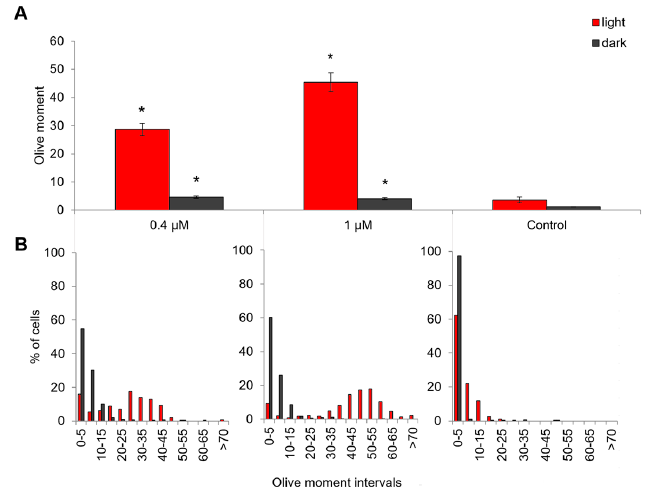
Figure 6. The level of DNA damage in HeLa cells in the dark and after activation with light ( λ = 660 nm), estimated with Comet assay (2 h in the dark then 20 min under red light then 6 h in the dark). At the Figure ( A ), there are average values of the six experimental repeats, within each repeat 50–80 cells were analyzed; At the Figure ( B ) the distribution of the number of cells according to Olive moment is shown with the interval being equal to five units in each variant. *—the difference from control (Solvent—DMSO in the dark) is significant at p <